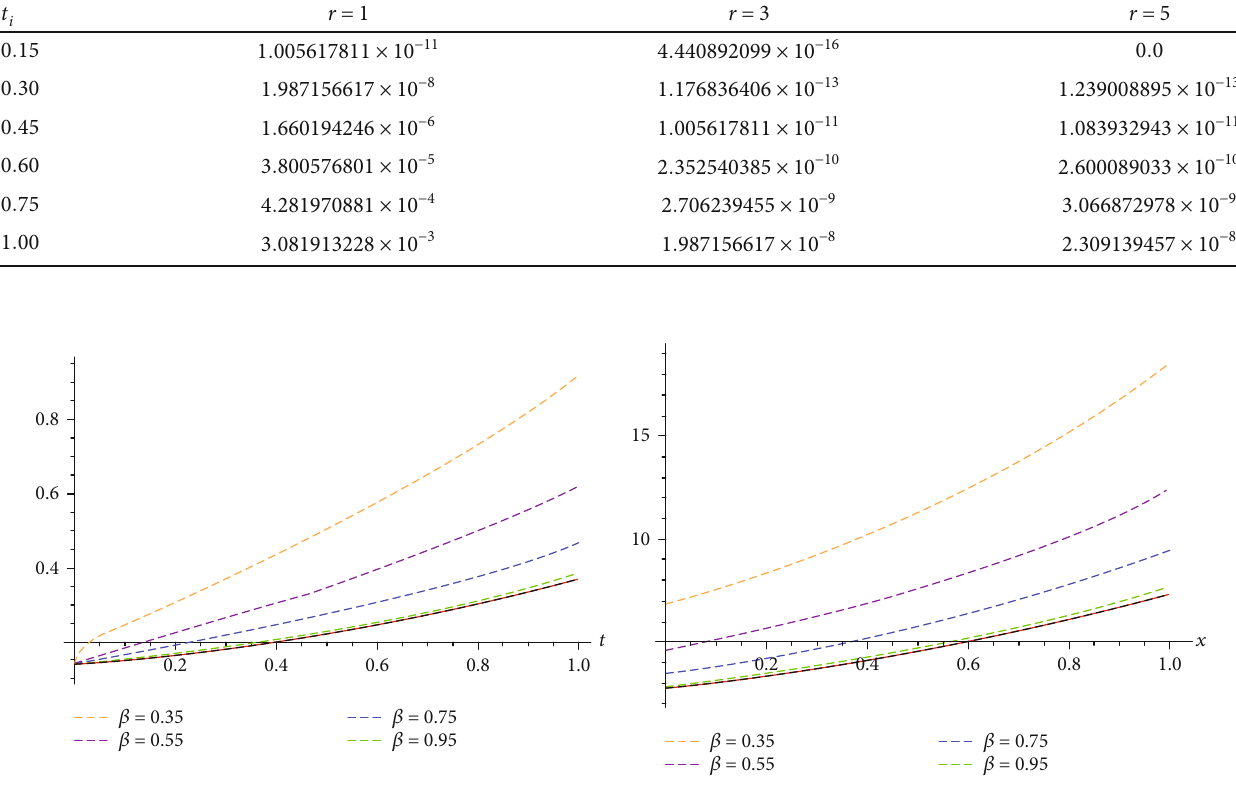
Figure 1: (a) Plots of exact solution w ð x , t Þ and 10 th -MFPS approximate solution w r = 5 ; (b) plots of exact solution w ð x , t Þ and 10 th -MFPS approximate solution w